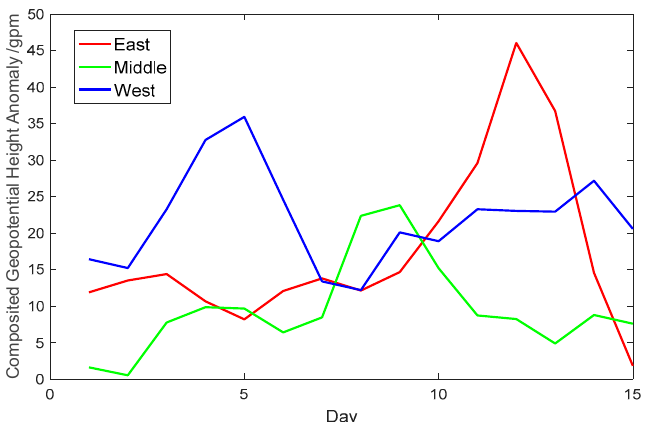
Figure 14. Temporal evolution of the three high-pressure anomaly centers: blocking high over the European continent (the blue line, located at 20° W–20° E; 40° N–70° N), the high-pressure anomaly over Mongolia (the green line, located at 40° E–80° E; 40° N–70° N), and the high-pressure anomaly over the west of Japan (the red line, located at 110° E–160° E; 40° N–70° N).